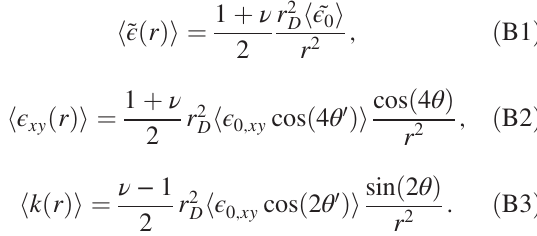
FIG. 9. (Top) The local-fit volumetric strain of a rearranger versus time. To average over different rearranging events, they are temporally aligned so that they start ( D 2 old) at t ¼ 0 . Rearrangements usually end at some time t between 10 2 and 10 3 . (Bottom) Same as left, except for local-fit xy -shear